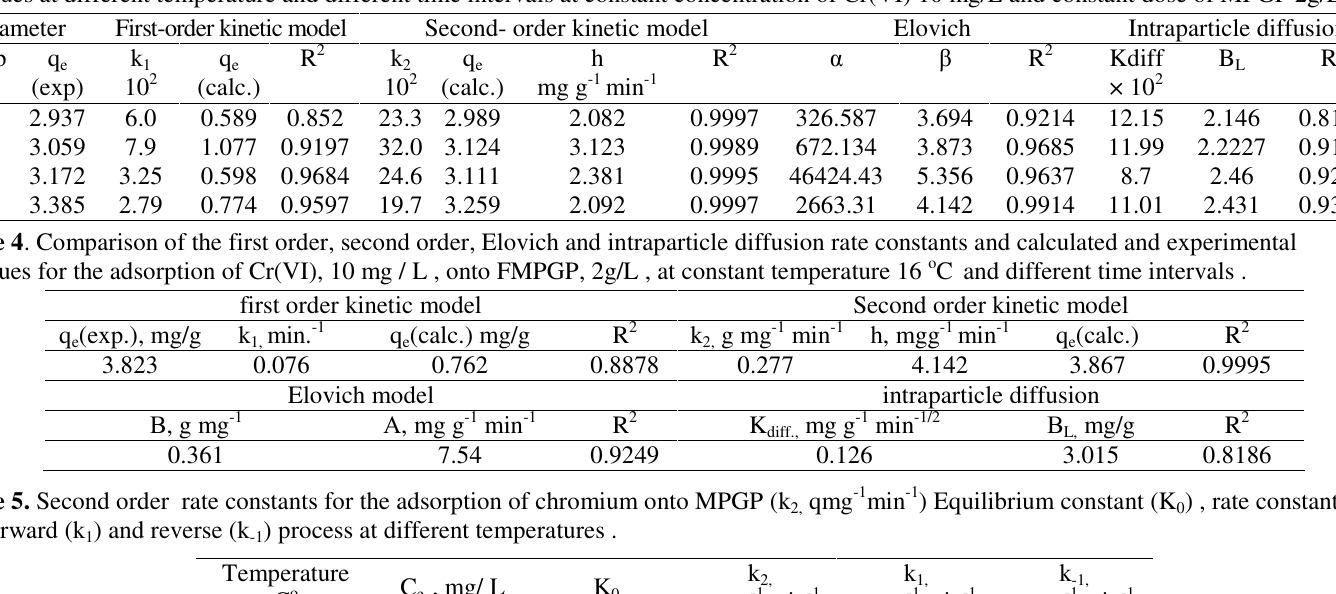
Table 3 . Comparison of the first order, second order , Elovich and intraparticle diffusion rate constants and calculated and experimental